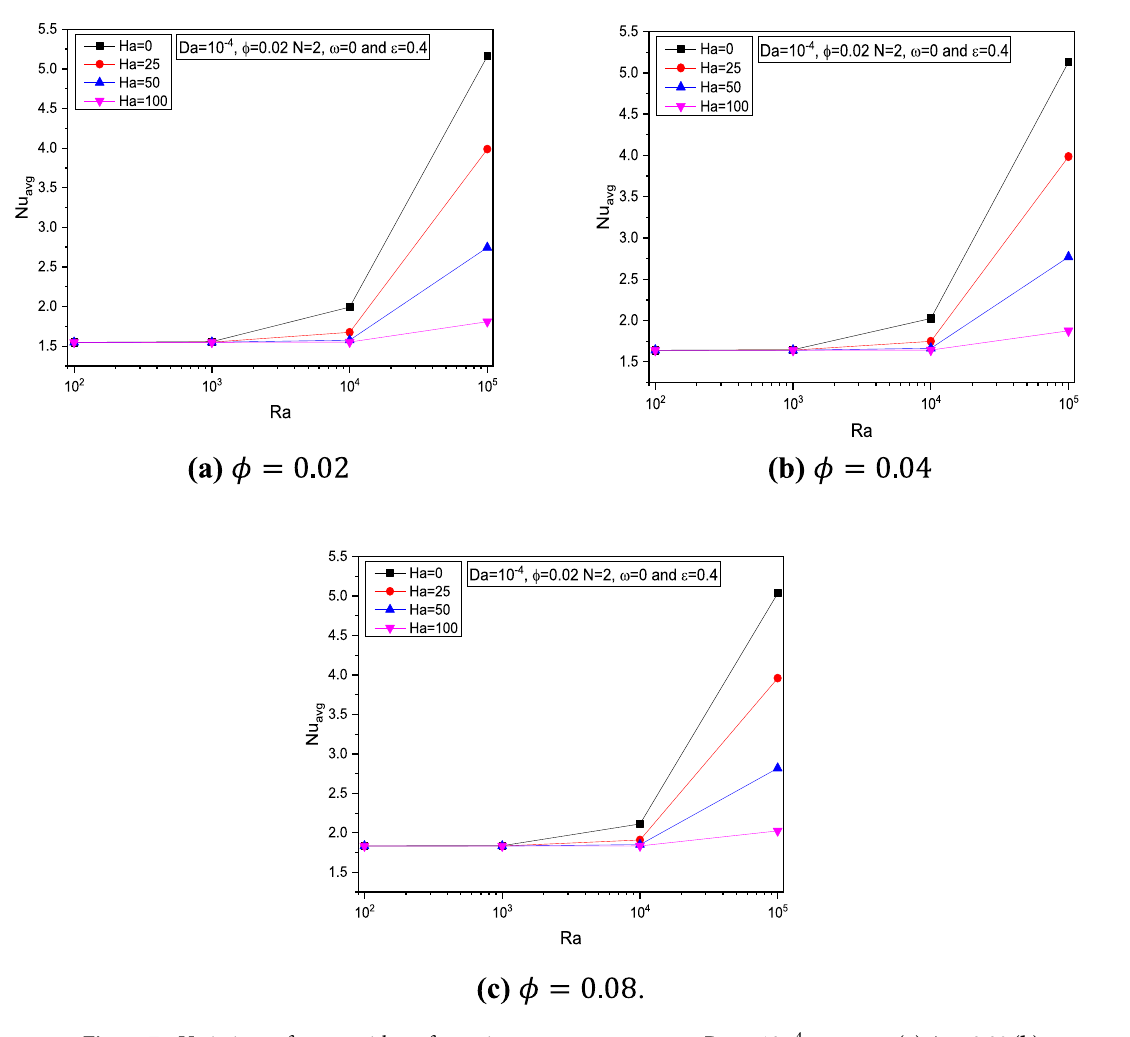
Figure 7. Variations of Nu avg with Ra for various Ha , ε 0.04 and ( c ) φ φ =